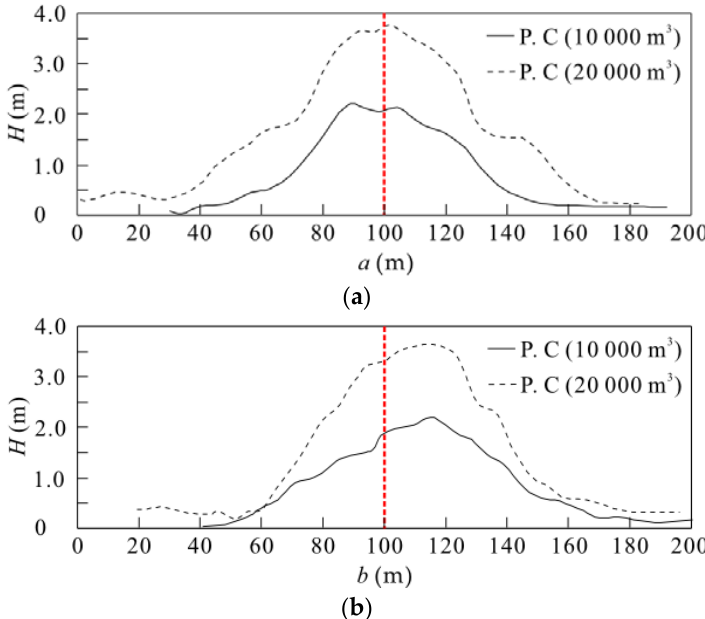
Figure 14. The cross ‐ sectional profiles along ( a ) horizontal direction and ( b ) longitudinal direction.